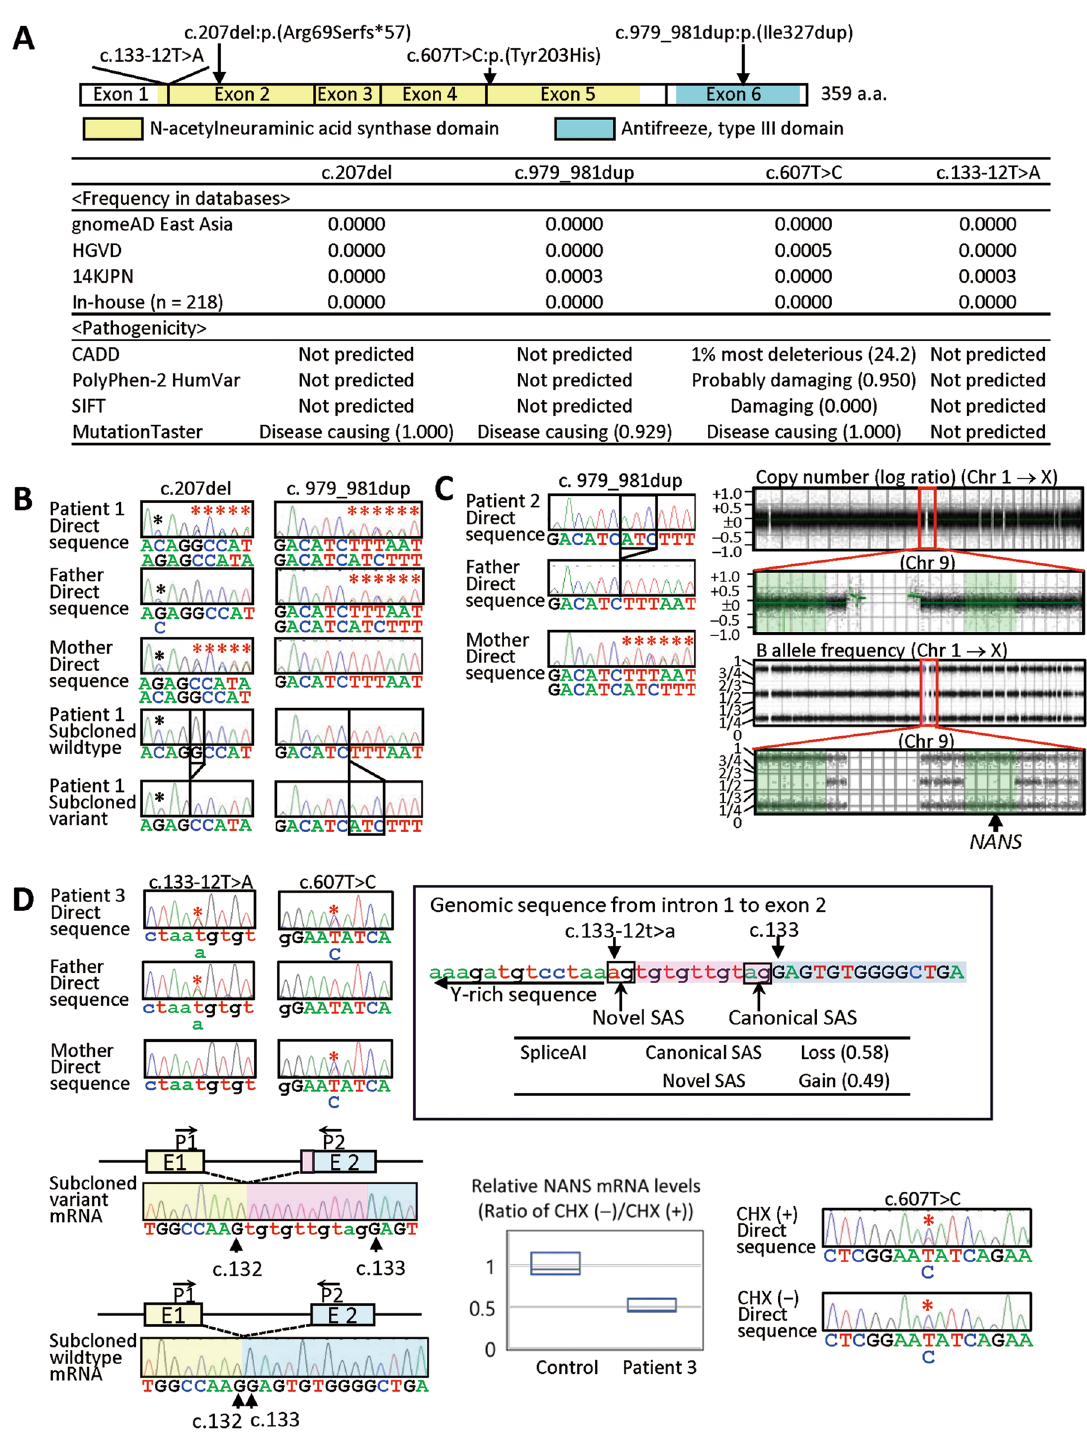
Figure 2. Molecular findings in patients 1–3. ( A ) The position and the frequency and pathogenicity of the NANS variants identified in this study (see also Supplementary Tables 1–3). ( B ) Molecular data in patient 1, showing the c.207del and c.979_981dup variants. Red asterisks indicate the frameshifted direct sequences. Black asterisks denote a G/C SNP (rs1058446; allele frequency, G 81% and C 19%). ( C ) Molecular data in patient 2, showing the homozygous and heterozygous c.979_981dup variant in patient 2 and the mother, respectively. Red asterisks indicate the frameshifted direct sequences. CytoScan HD analysis reveals the normal copy number and segmental loss of heterozygosity for chromosome 9, indicating segmental isodisomic regions involving NANS (highlighted with light green). ( D ) Molecular data in patient 3, showing the c.133–12T>A and c.607T>C variants (indicated with red asterisks). The c.133–12T>A creates a novel splice acceptor site (SAS) which is predicted to be utilized more preferentially than the canonical SAS by SpliceAI and produce an aberrant mRNA subject to NMD. Consistent with this, experiments using mRNA samples reveal a variant mRNA containing 10 bp intronic sequence on the electrochromatogram for subcloned mRNAs, a roughly halved mRNA expression ratio between CHX-untreated and CHX-treated LCLs, and a reduced wildtype "T" peak for the c.607T>C variant on the electrochromatogram obtained by direct sequencing for the CHX untreated LCLs (indicated with red